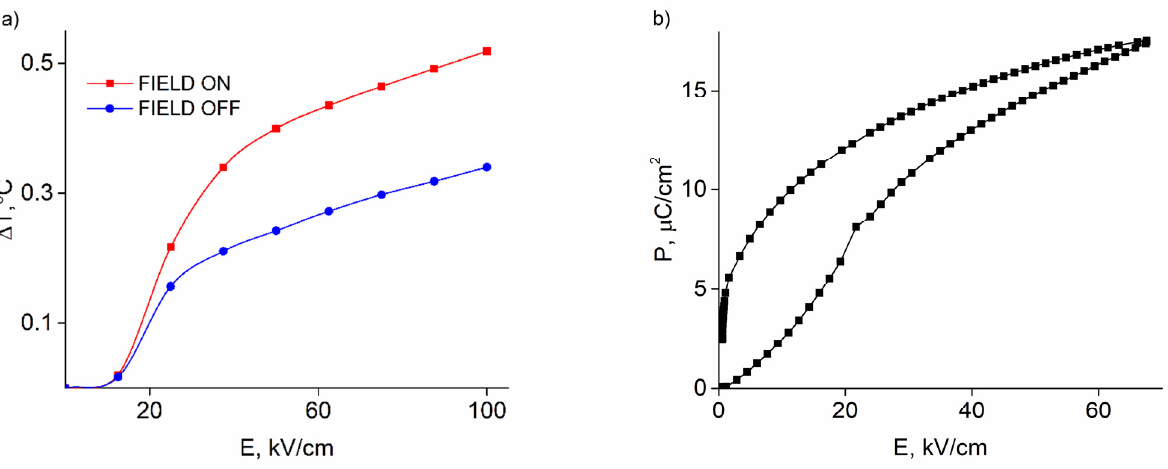
Figure 6. Δ T(E) ( a ) and P(E) ( b ) for (1 − x)(0.8NBT-0.2BT) − xCT composition with x = 0.075 at 40 ° C ( P(E) is measured at E = 67 kV/cm unipolar pulse).